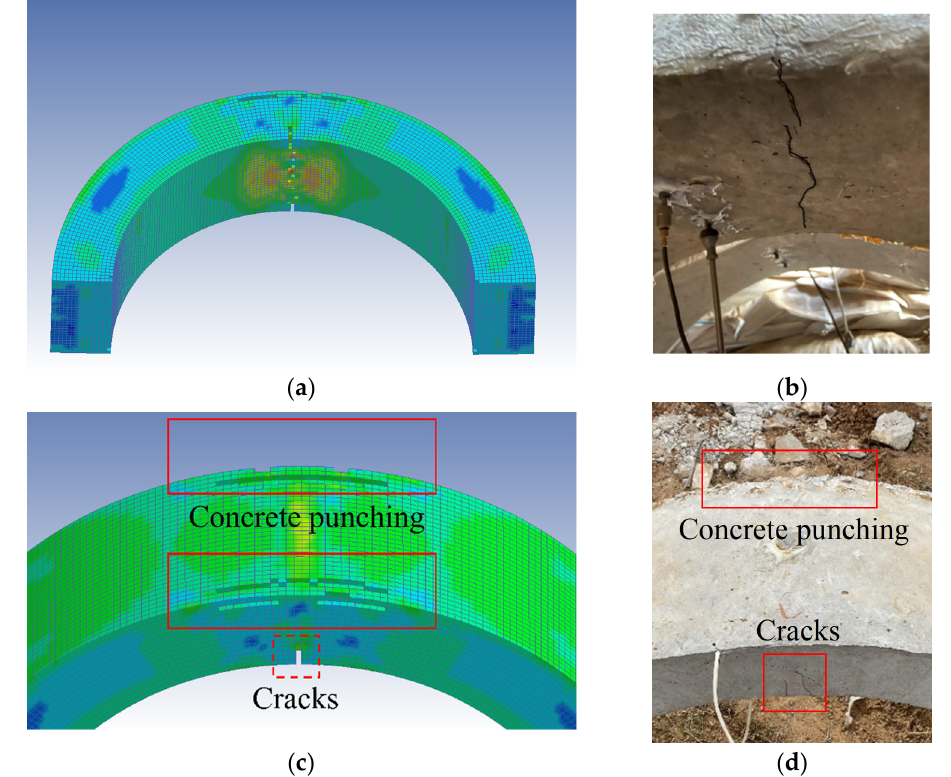
Figure 6. The penetrating concrete cracks of inner sides of ( a ) the simulated and ( b ) the experimental arch, the failures on the lateral sides of the vault of ( c ) the simulated and ( d ) the experimental arch.